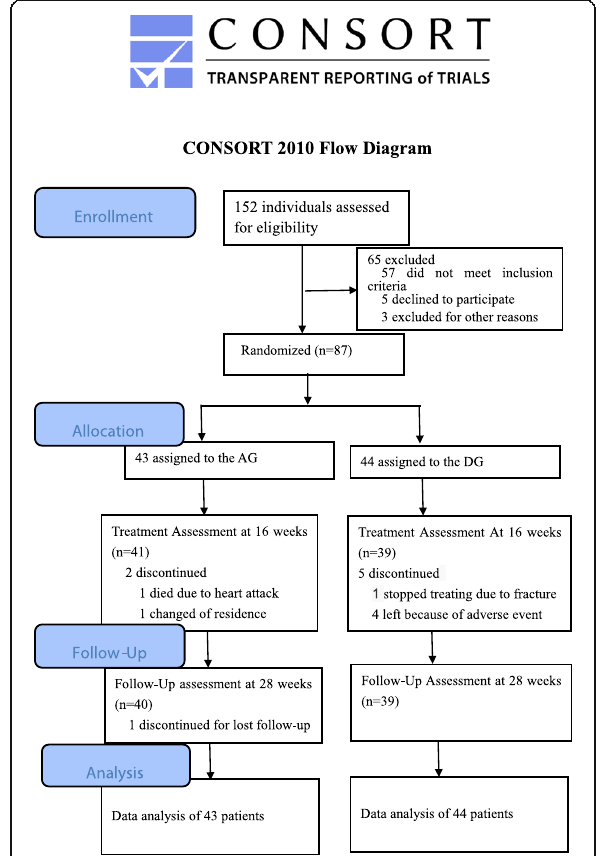
Fig. 1 Flowchart of the study design (based on CONSORT 2010